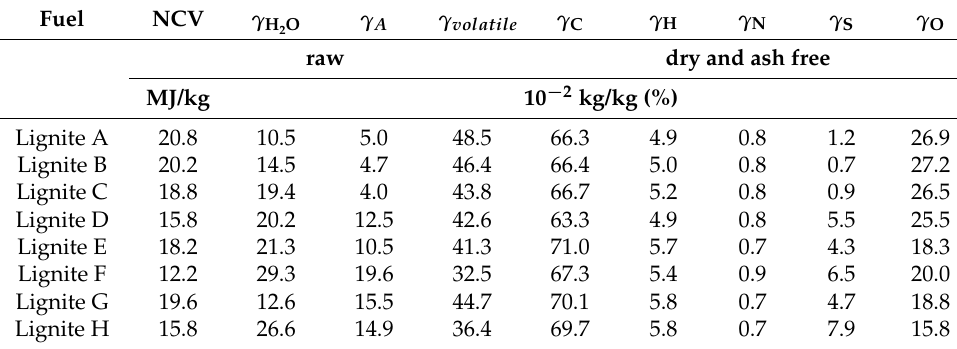
Table 1. Chemical properties of pre-dried lignite qualities.